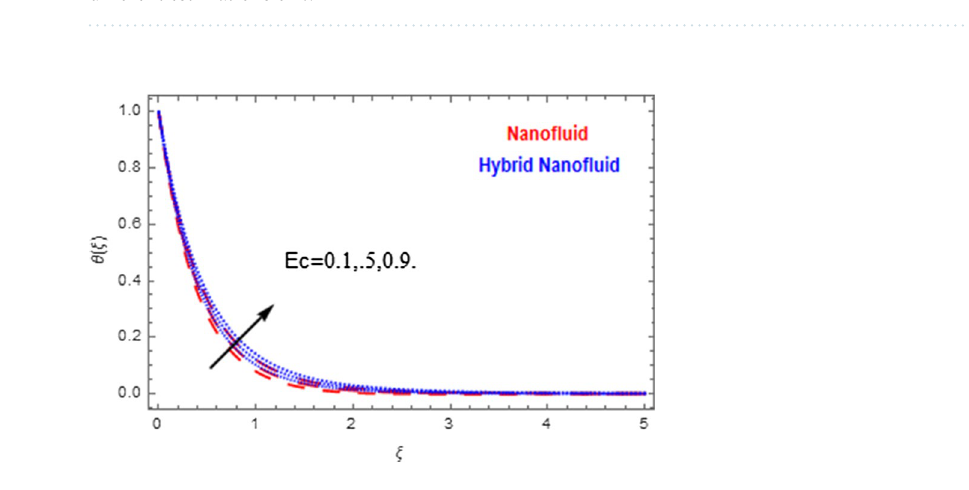
Figure 14. Variation in temperature field of nanofluid ( Al 2 O 3 ) and hybrid nanofluid ( Al 2 O 3 , Cu ) against different estimations of Ec